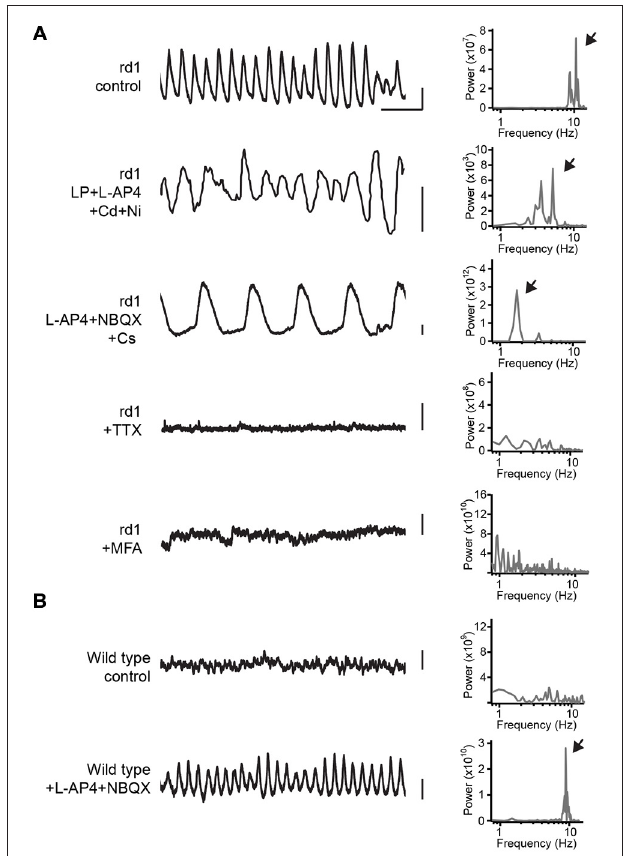
FIGURE 1 | Pharmacological analysis of spontaneous oscillations in AII amacrine cells. (A) On the left are shown plots of the membrane potential of AII amacrine cells in rd1 retina in control and in a set of different pharmacological agents. The top trace and bottom three traces were recorded in whole-mount retina. The second trace from the top is adapted from Figure 9C from Choi et al. (2014). A power spectral analysis is shown to the right of each voltage trace, and arrows point to the frequency of the oscillation. (B) The same as (A) , except for wild type retina, see also data used in Trenholm et al. (2012). Abbreviations: LP, linopirdine dihydrochloride (M-type K + channel blocker); L-AP4, L-(+)-2-amino-4-phosphonobutyric acid (mGluR6 receptor agonist); Cd, cadmium chloride (voltage-gated Ca 2 + channel blocker); Ni, nickel chloride (voltage-gated Ca 2 + channel blocker); NBQX, 2,3-dihydroxy- 6-nitro-7-sulfamoyl-benzo[f]quinoxaline-2,3-dione (AMPA/Kainate receptor antagonist); Cs, cesium (I h blocker); TTX, Tetrodotoxin (voltage-gated K + channel blocker); MFA, meclofenamic acid (gap junction blocker). Scale bar is 500 ms for x -axis; 3 mV for y -axis.